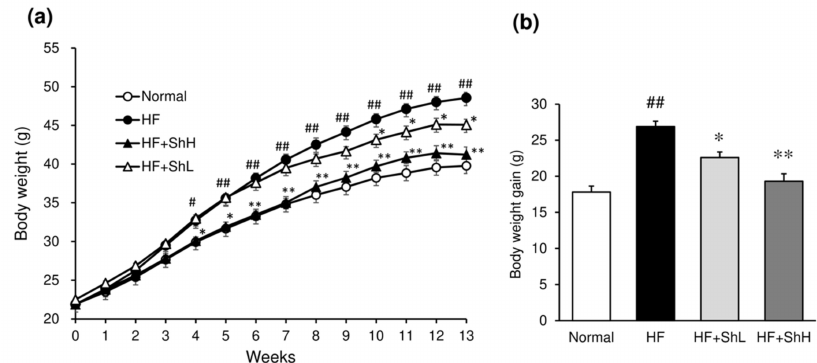
Figure 1. Effects of S. horneri on the body weight in C57BL/6J mice fed a high-fat diet for 13 weeks. ( a ) Weekly changes in the body weight; ( b ) body weight gain. Normal, normal diet; high-fat (HF), high-fat diet; HF + ShL, high-fat diet mixed with 2% S horneri ; HF + ShH, high-fat diet mixed with 6% S. horneri . Each value represents the mean ± SEM ( n = 12 − 13). Significant difference: * p < 0.05, ** p < 0.01 vs. HF group, # p < 0.05, ## p < 0.01 vs. Normal group.